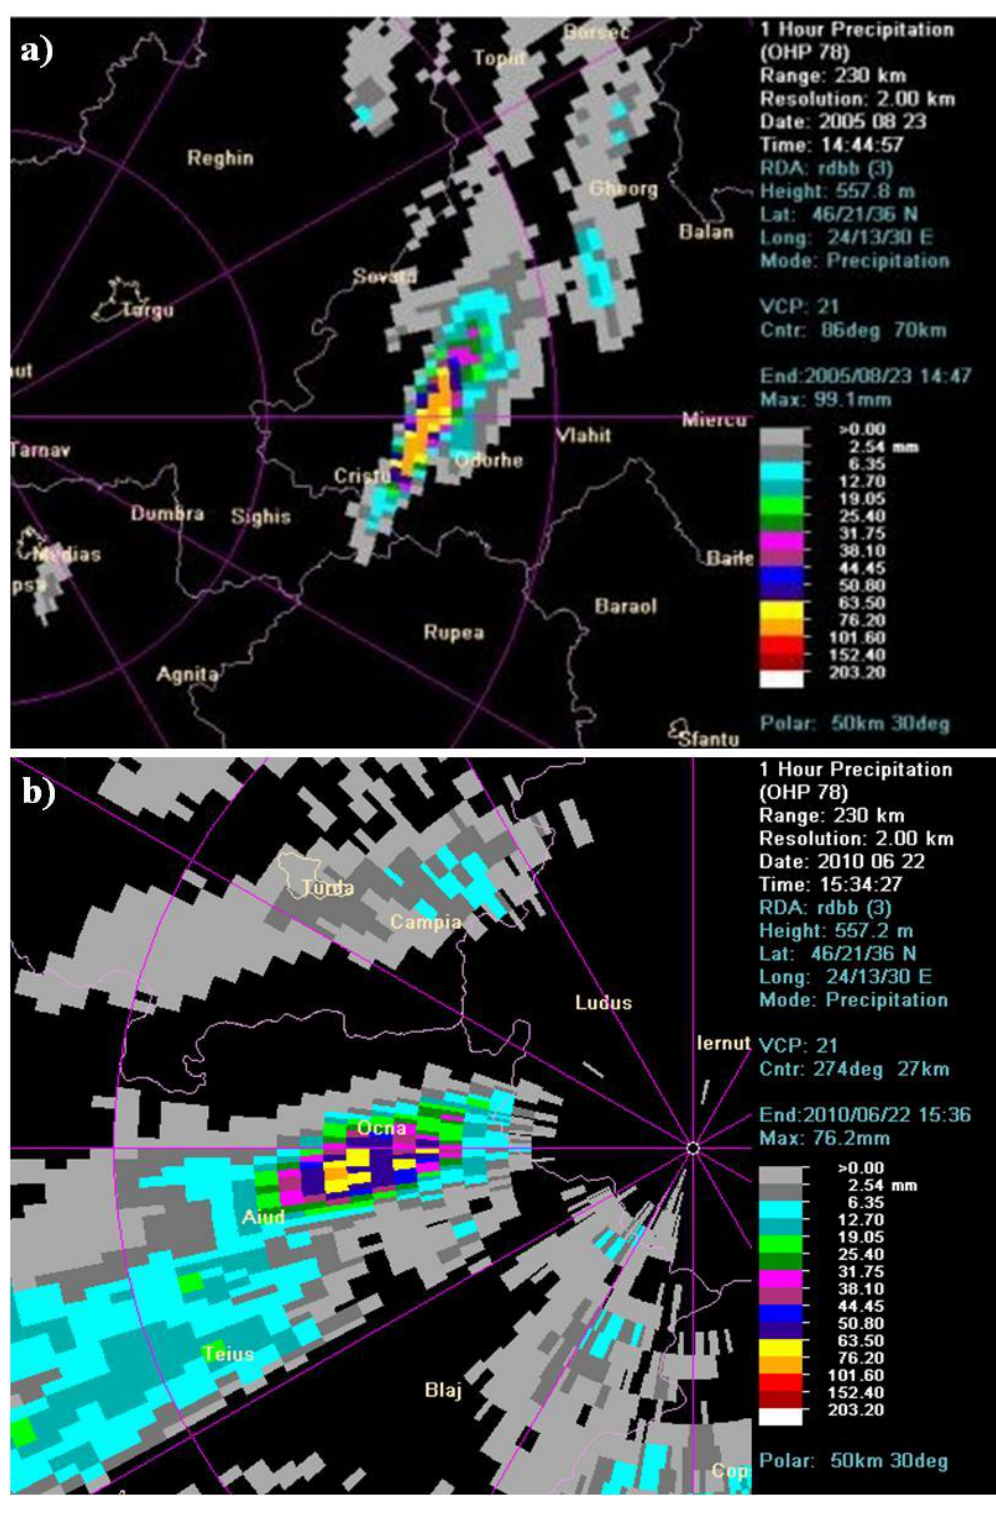
Fig. 3. The estimation of rainfall rates (mmh − 1 ) with the Doppler radar in the (a) Feernic and (b) Ciunga basinal areas (source of radar images: “Transilvania Nord” regional meteorological center Figure 3. The estimation of rainfall rates ( ) with the Doppler radar on (a) Feernic and (b) Ciunga basinal areas (source of radar images: Regional Meteorological Center „Transilvania Nord’’).